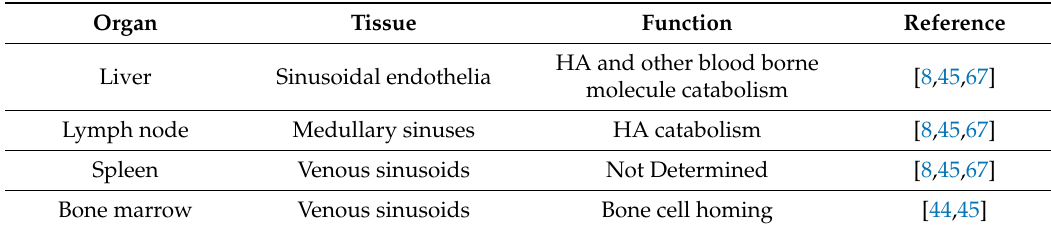
Table 1. Expression and Function of Stabilin-2 /